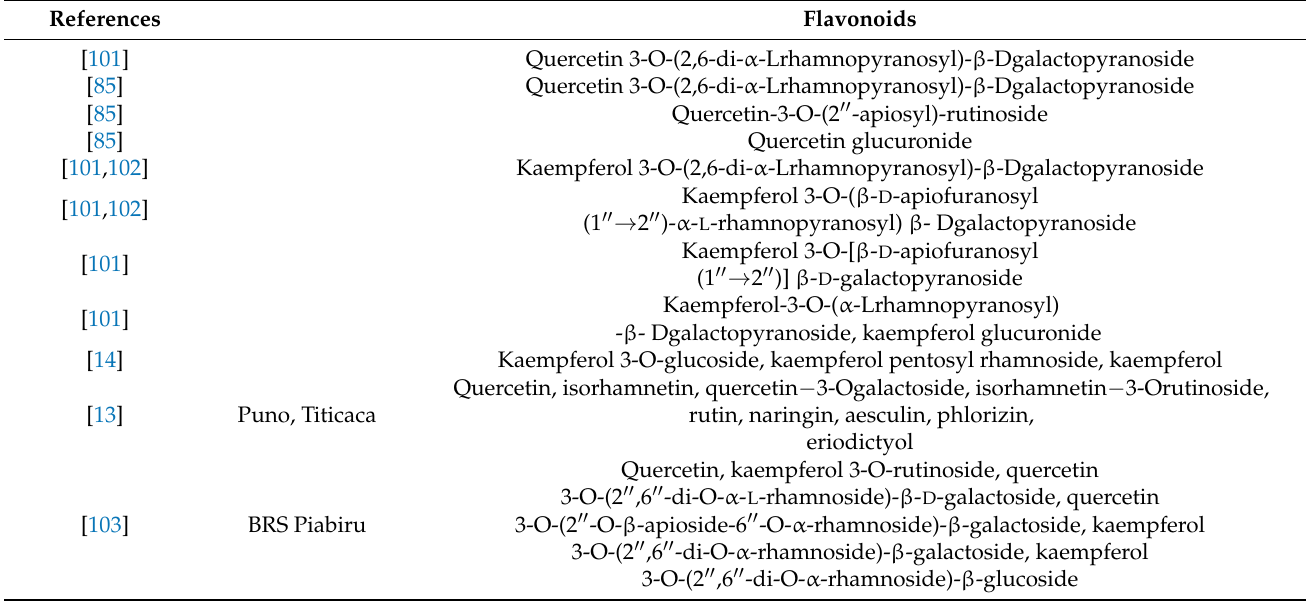
Table 4. Secondary metabolites (flavonoid) identified from different quinoa